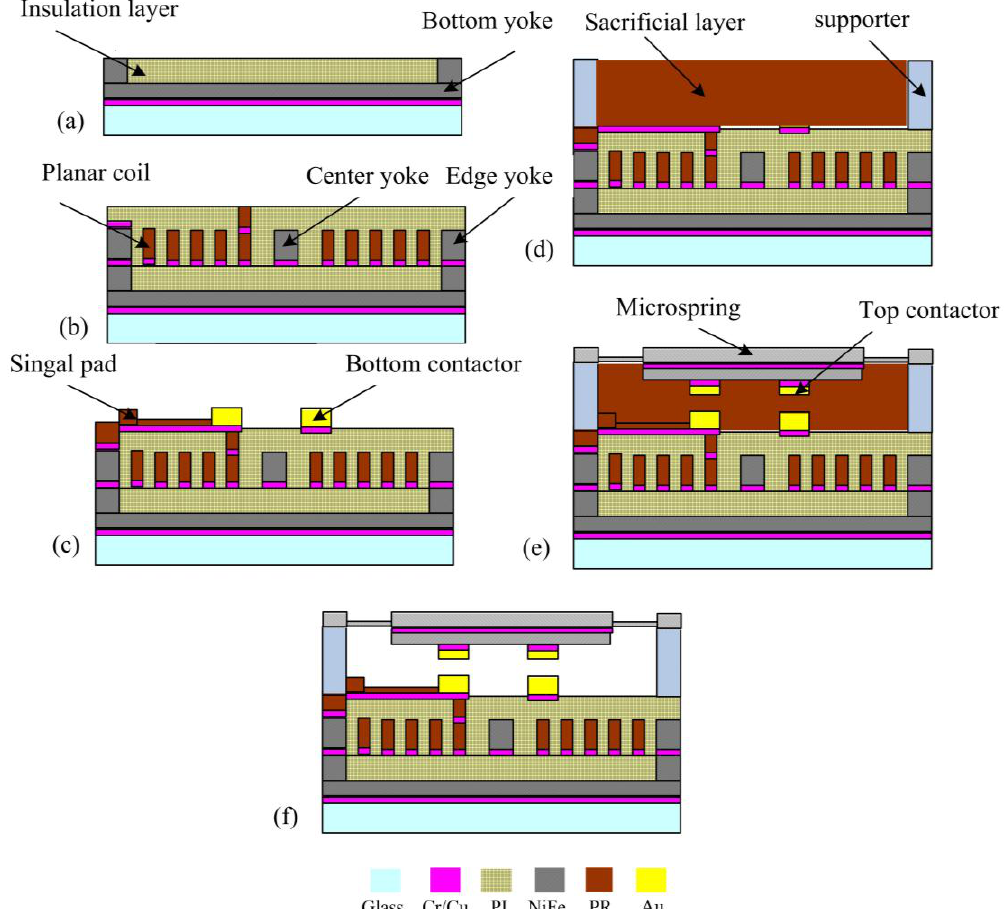
Figure 10. Microfabrication process of the microswitch on a single glass wafer. ( a ) bottom yoke electroplating; ( b ) coil electroplating; ( c ) bottom contactor electroplating; ( d ) supporter electroplating; ( e ) microspring electroplating; ( f ) releasing of device.